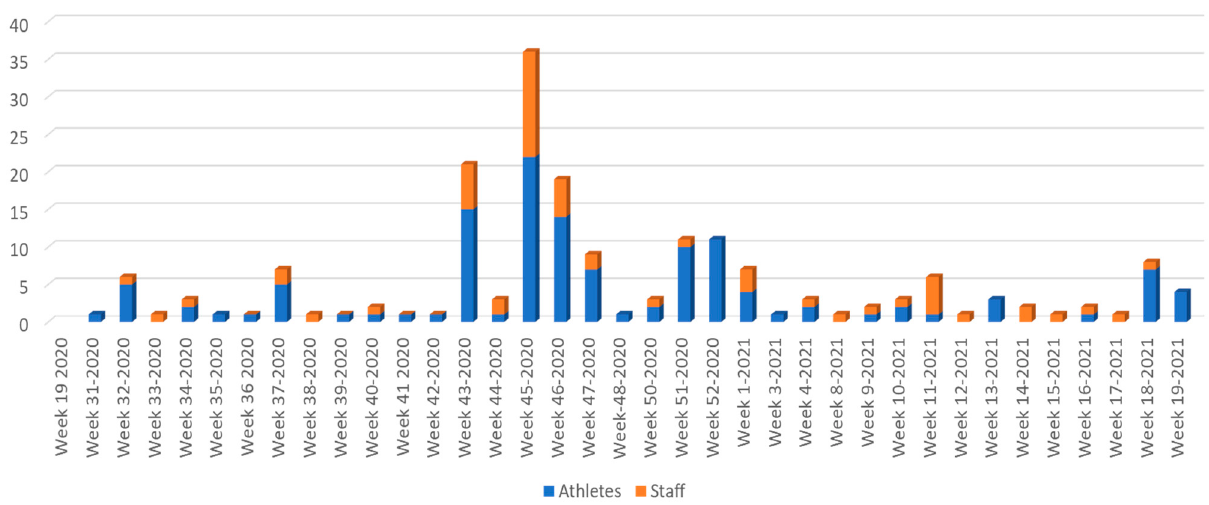
Figure 1. Weekly confirmed cases in athletes and staff in Super League